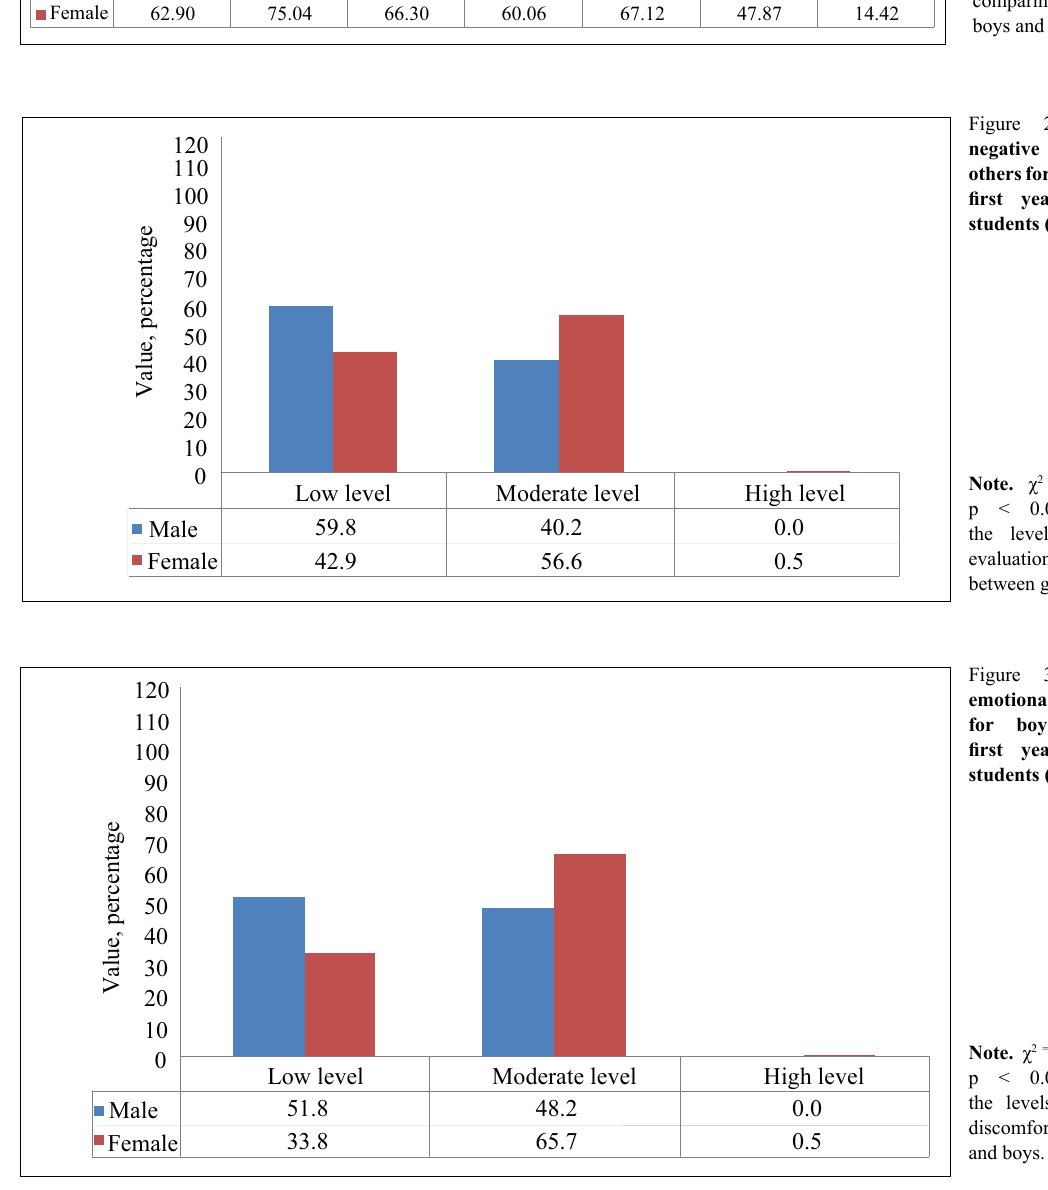
Figure 3. Levels of emotional discomfort for boys and girls, first year gymnasium students